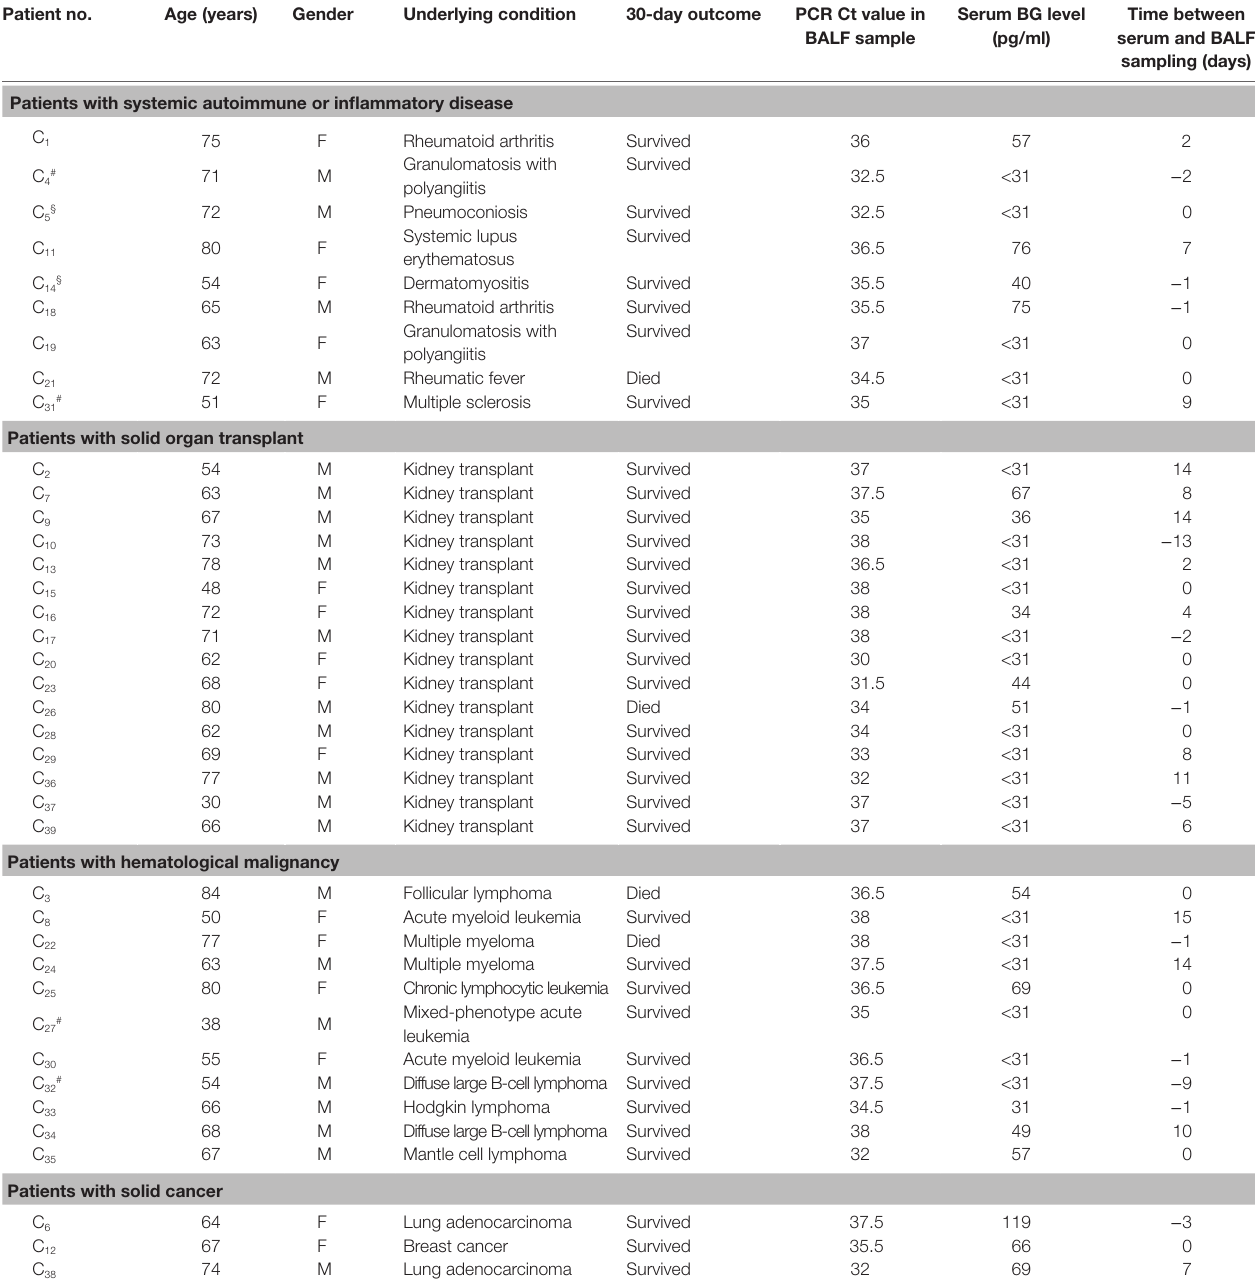
TABLE 2 | Characteristics of the 39 patients colonized by Pneumocystis . Patient no. Age (years) Gender Underlying condition 30-day outcome PCR Ct value in